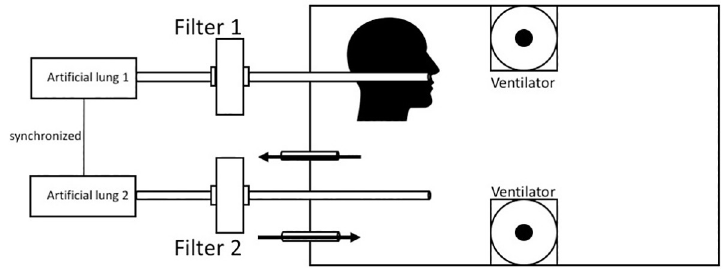
Fig 2. Schematic setup. Schematic drawing of the setup seen in Fig